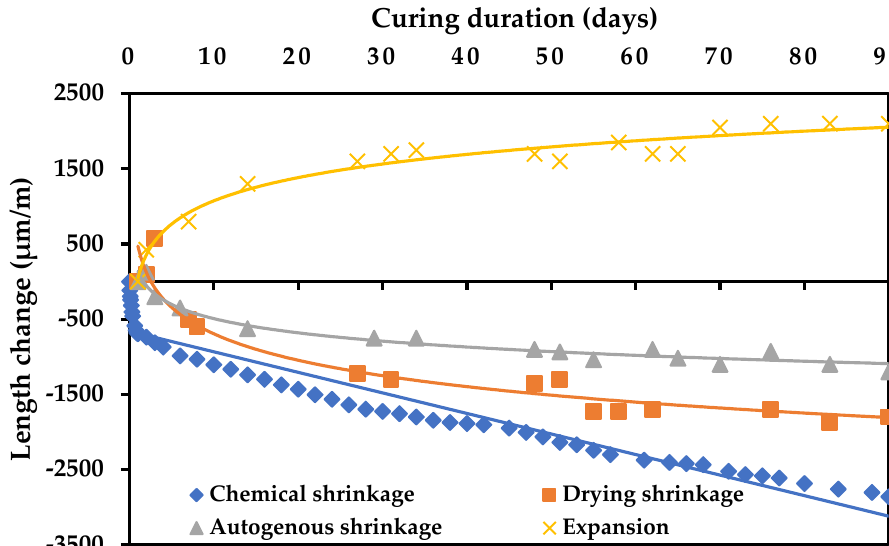
Figure 13. Length change of pastes with 15% LF.